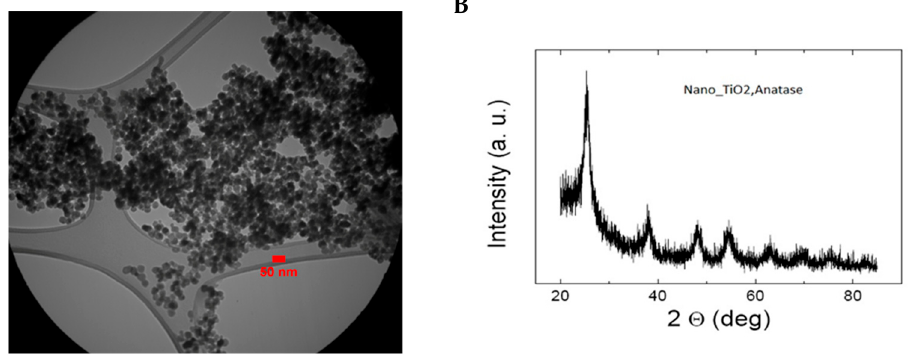
Figure 2. Representative high-resolution transmission electron microscopy image ( A ) and X-ray diffraction pattern of TiO 2 nanoparticles ( B ).